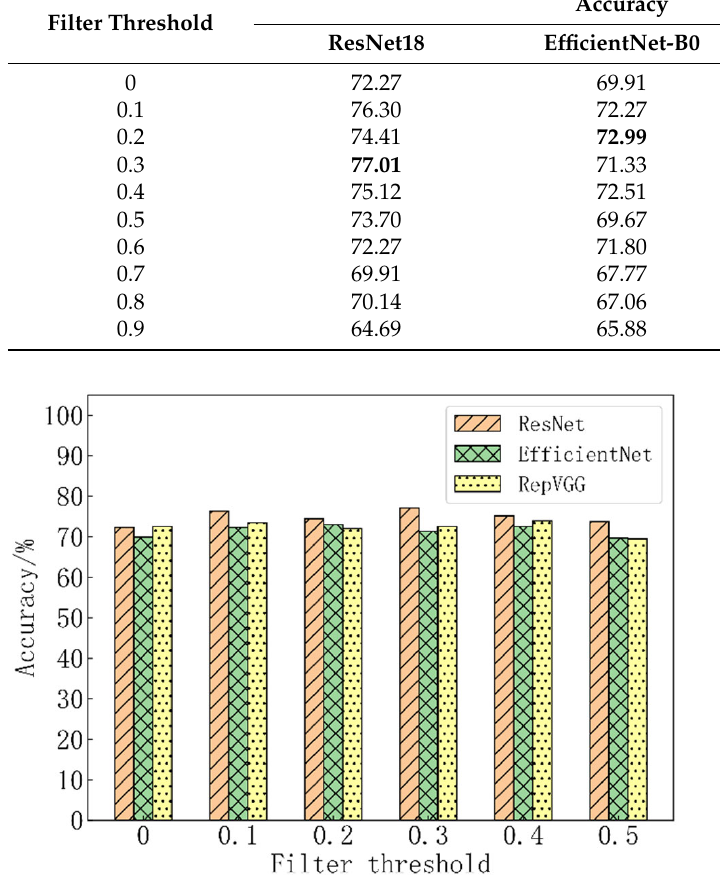
Figure 7. Variation of model accuracy with filter threshold. Table 5. Image numbers for spherular pearlite gradation with each filter threshold.